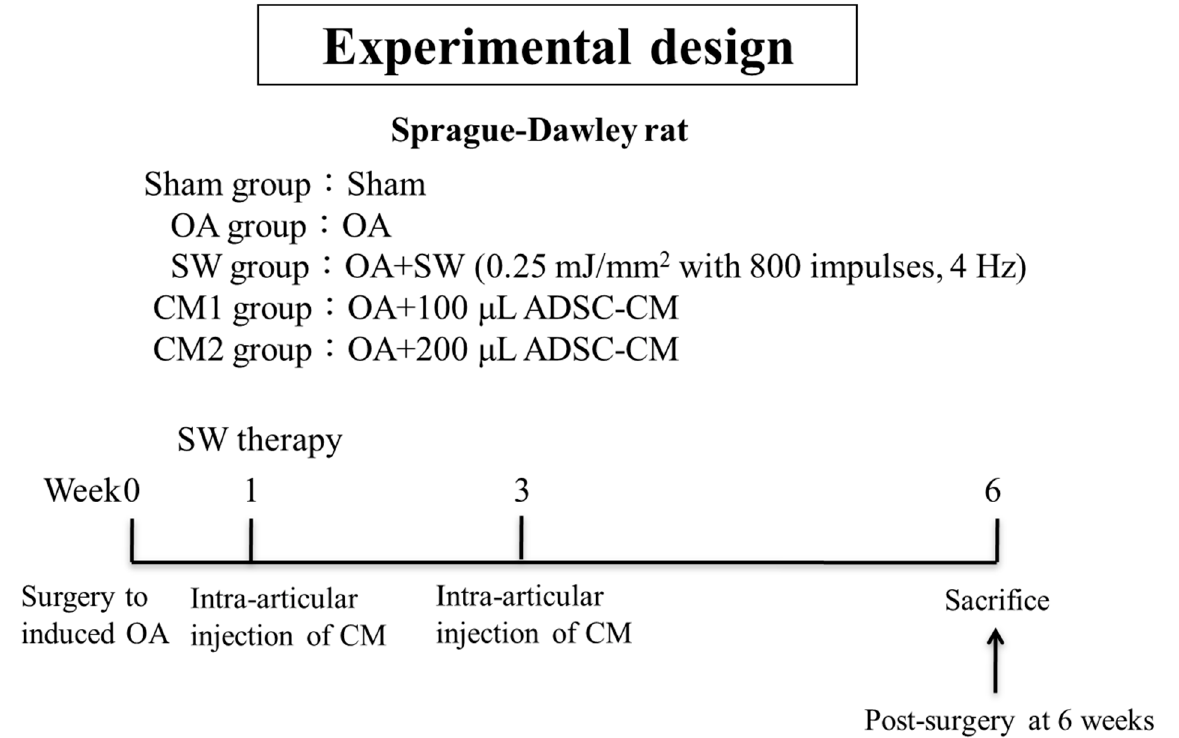
Figure 1. The study design. The graph displays the study design of the experiment including knee surgery (osteoarthritis; OA), shockwave (SW) application, 100 and 200 µ L adipose-derived mesenchymal stem cells-conditioned medium (ADSC- CM) injections at 1- and 3-weeks post-surgery, respectively, and sacrifice of animals at 6 weeks post-surgery. Eight rats were used for each group.